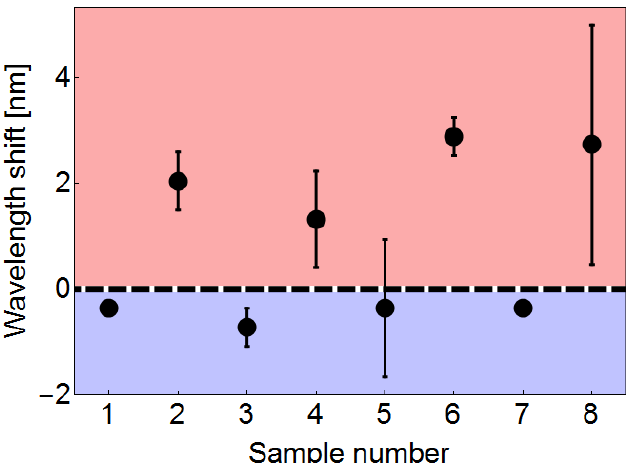
Figure 6. Wavelength shift as a function of sample number (see Table 1). Positive wavelength shifts represent a shift to longer wavelengths. Each symbol represents the mean value obtained from three MMI devices (see text). The bars represent the standard deviation.